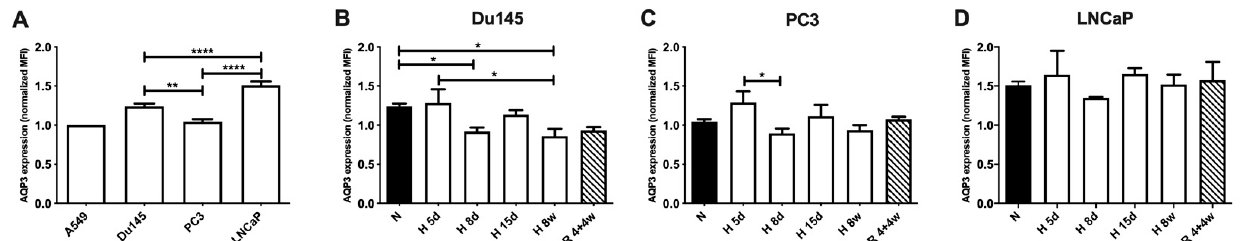
Figure 1. Total AQP3 protein expression in prostate cancer cells under normoxia (N—20% O 2 ), hypoxia (H—1% O 2 ) and recovery (R—hypoxia followed by normoxia). All data were normalized to the corresponding AQP3 expression in A549, under normoxia, within the same experiment. ( A ) AQP3 expression in all cell lines under normoxia. AQP3 expression for ( B ) Du145, ( C ) PC3 and ( D ) LNCaP cells under normoxia, acute hypoxia (5 d, 8 d, 15 d—days 5, 8 and 15), chronic hypoxia (8 w—8 weeks) and recovery (R 4 + 4 w—4 weeks hypoxia + 4 weeks normoxia). Data represent mean ± SEM of a minimum of three independent experiments. **** p < 0.0001 ** p < 0.01 * p < 0.05.